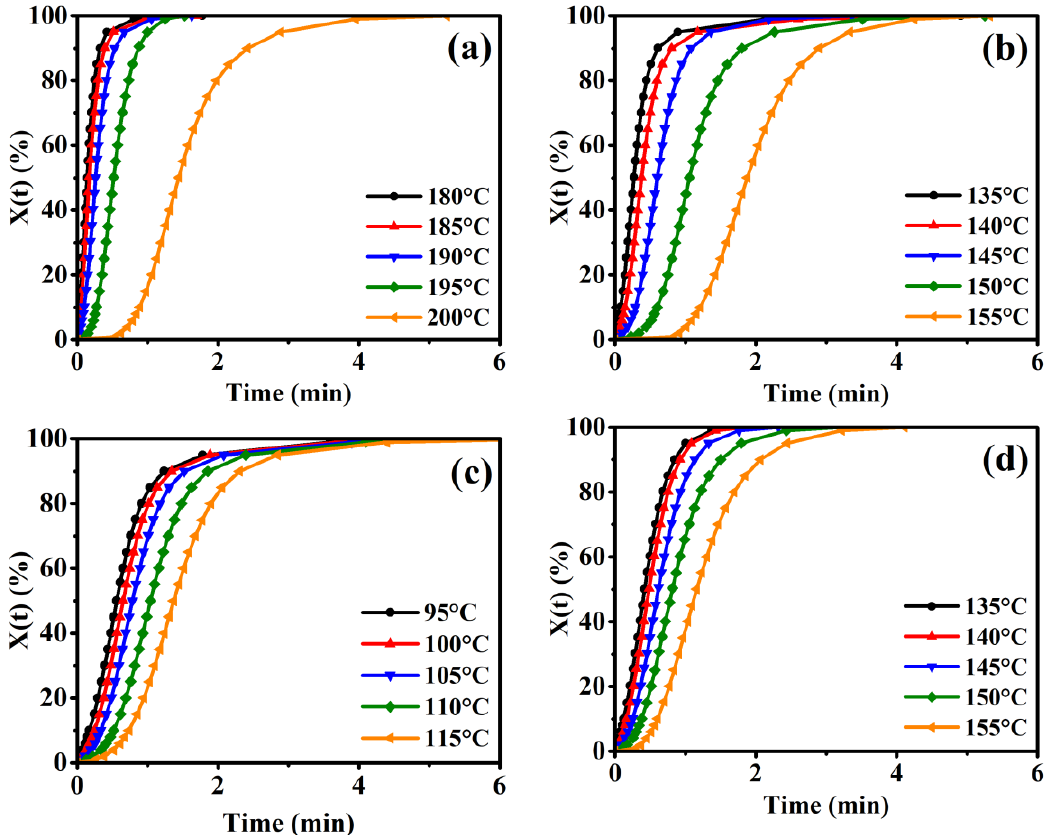
Figure 4. The relationship of the relative crystallinity versus the crystallization time during the different isothermal processes for the ( a ) pure PA6, ( b ) PA6-5, ( c ) PA6-10, and ( d ) PA6-15.